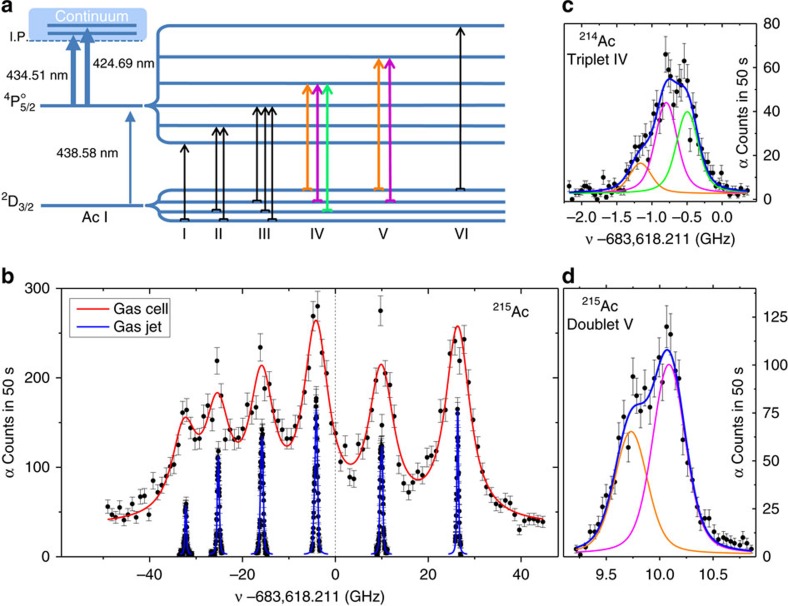
Gas cell versus gas jet spectra.(a) Ionization scheme with vacuum wavelengths for the excitation and ionization steps along with the expected hyperfine splitting for the 212–215Ac isotopes indicating (not to scale) the 12 hyperfine transitions grouped in six (I to VI) multiplets. (b) Measured spectra (black dots) of the hfs in the 6d 7s2
 transition from the ground state shown as the α-counts collected in 50 s versus the frequency detuning ν with respect to the value of the centre of gravity. The gas-cell data has been corrected for the pressure shift (see Methods section). The red (blue) curve shows the best fit of a 12-peak Voigt profile to the data from laser spectroscopy studies in the gas cell (gas jet). (c,d) Zoom in of the triplet (number IV) and doublet (number V) hyperfine transitions in 214Ac and 215Ac, respectively, for the typical average energy per pulse of 0.8 μJ of the excitation laser radiation. The colour code used to show the different components of the multiplets indicates the corresponding hyperfine transitions as seen in the excitation scheme in a. One sigma s.d. as statistical errors are reported in all the data points.